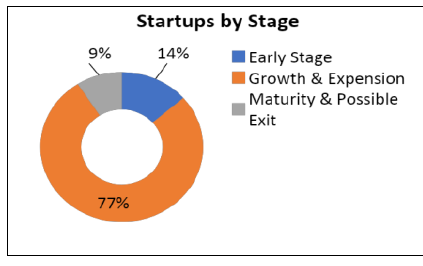
Figure 8: Startups by Stage of